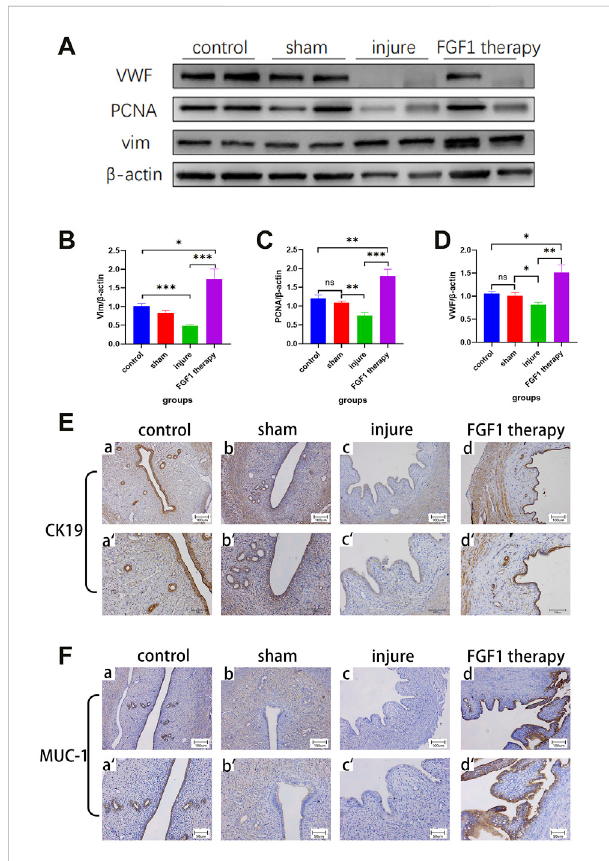
FIGURE 3 FGF1 promotes the expression of endothelial cell proliferation and angiogenic markers. The results of PCNA, vim, vWF and corresponding total protein Western blot (A) . Statistical analysis of PCNA,vimandvWFWesternblotoutcomes.n=7,ns > 0.05,* p < 0.05, ** p < 0.01, *** p < 0.001 (B – D) . Expressions of CK19 and MUC-1 in glandular epithelial and luminal epithelium cells of endometrium with IHC staining. a-d 100X, a ’– d ’ 200X (E , F)